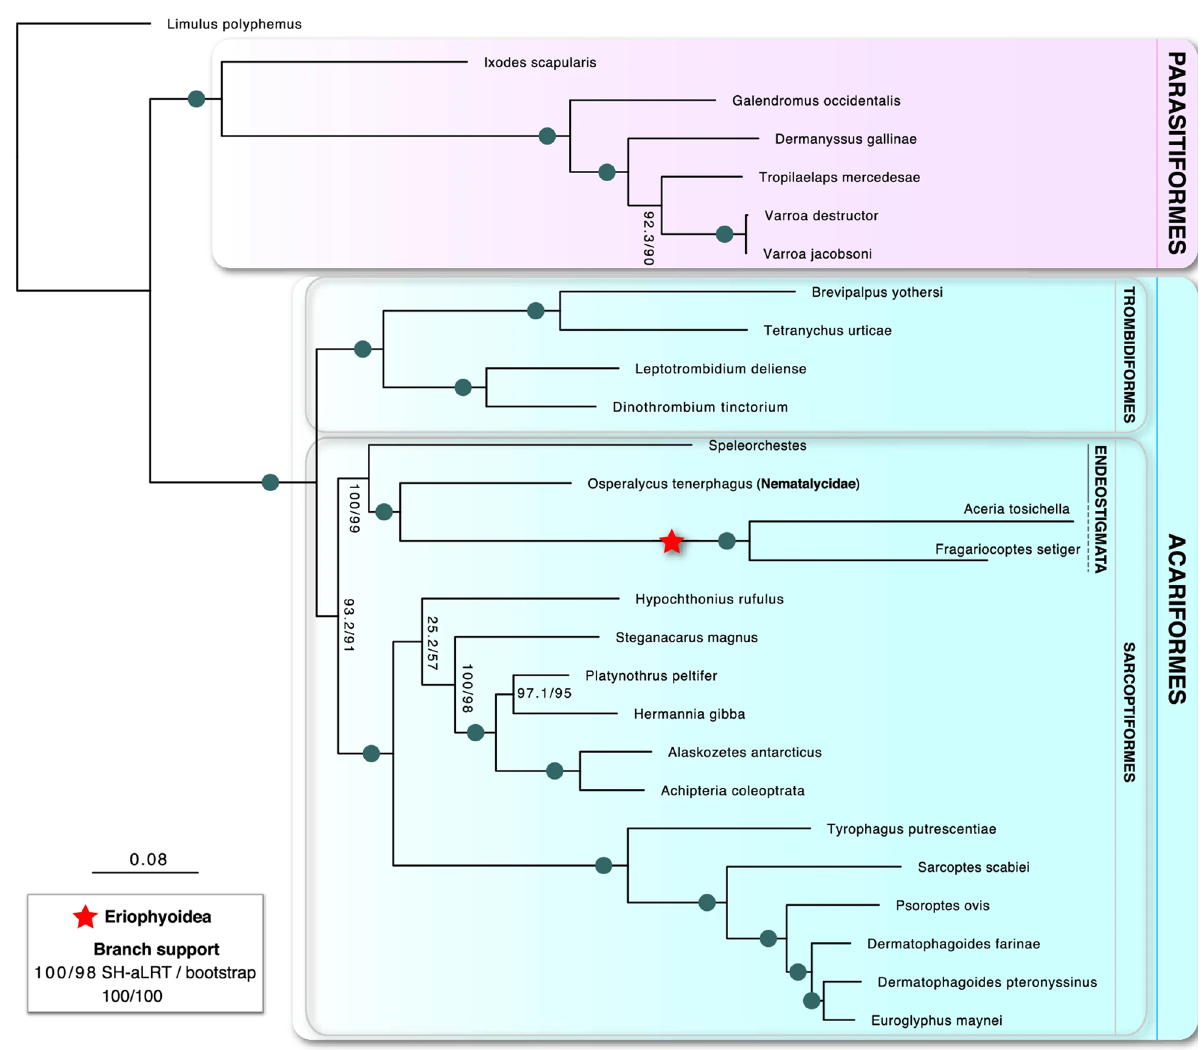
Figure 2. Relationships of parasitiform and acariform mites. Phylogenomic inference was undertaken using a Maximum likelihood framework in IQ-TREE based on 90 orthologous